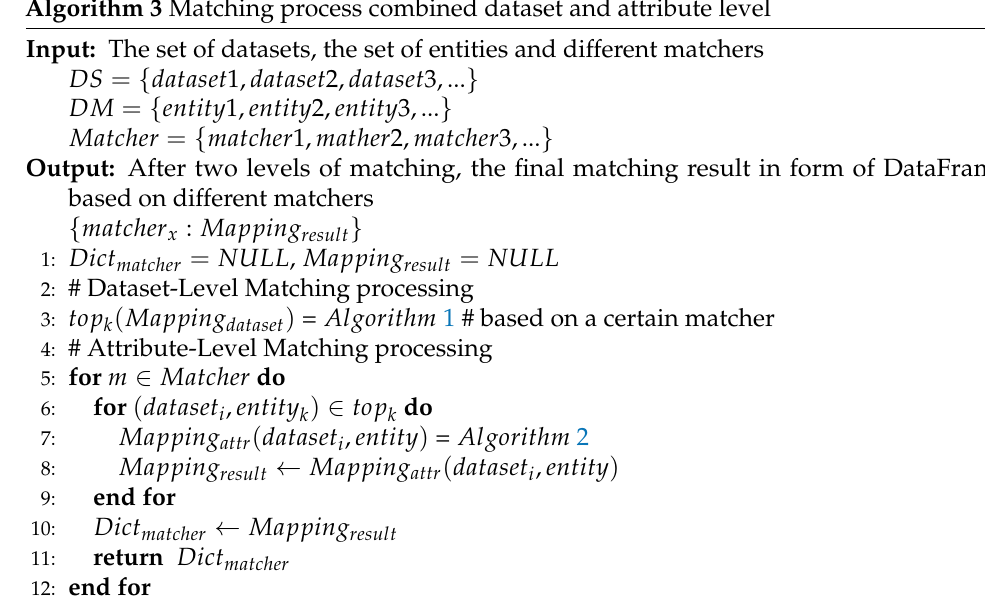
Algorithm 3 Matching process combined dataset and attribute